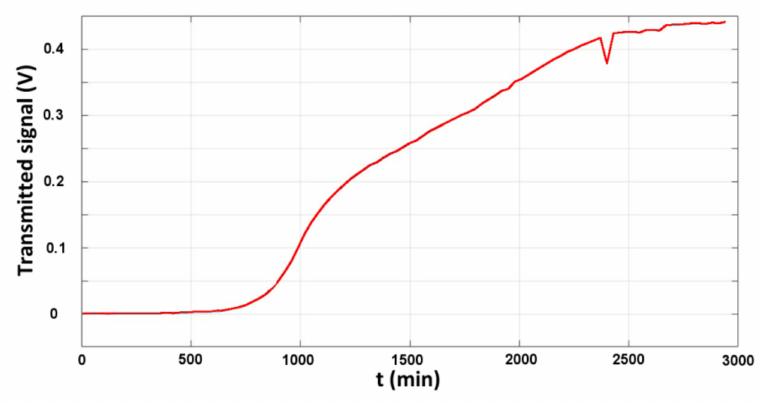
Figure 26. Transmission of the fresco sample during the drying process.